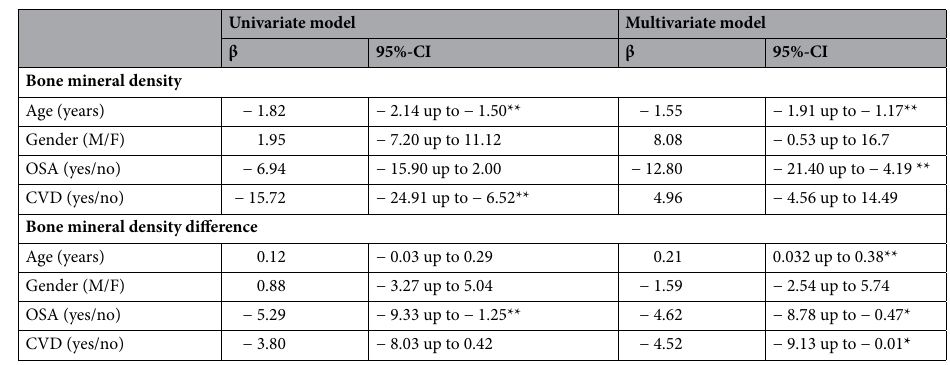
Table 4. Univariate and Multivariate linear regression model on BMD and BMD difference alteration. β unstandardized β, Bone Mineral Density (BMD) of combined 12 thoracic vertebrae and first lumbar vertebra scans. Data include participants who were not administered a contrast agent, OSA obstructive sleep apnea diagnosis (apnea–hypopnea index ≥ 5 events/h), CVD cardiovascular disease, F females, M males. * p = 0.05, ** p <